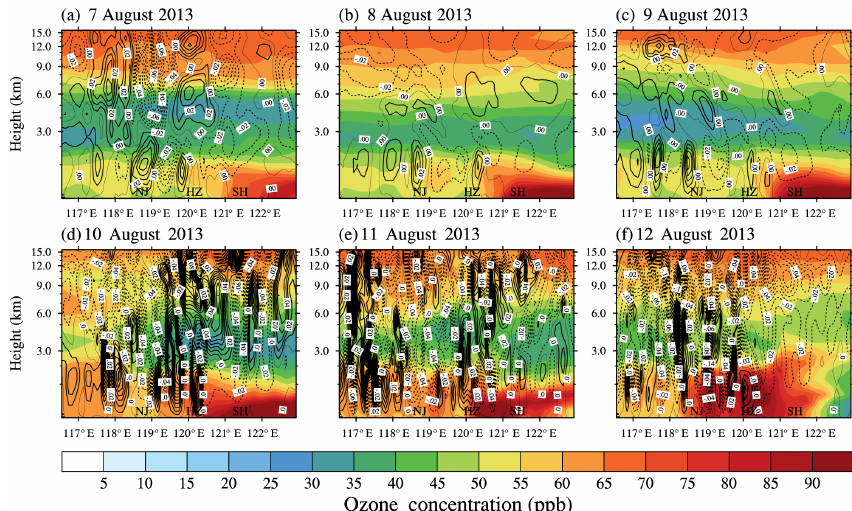
Figure 7. Simulated daytime vertical wind velocity and vertical distribution of O 3 concentrations from 116.5 to 122.9 ◦ E along the latitude of 31.40 ◦ N (where Shanghai is located) during 7 to 12 August 2013. The marks of SH, HZ and NJ point out the longitudes of Shanghai, Hangzhou and Nanjing, respectively. The dotted lines show the negative wind speeds and represent downward airflow, while the solid lines show the positive wind speeds and zero vertical velocity. The interval is 0.01ms − 1